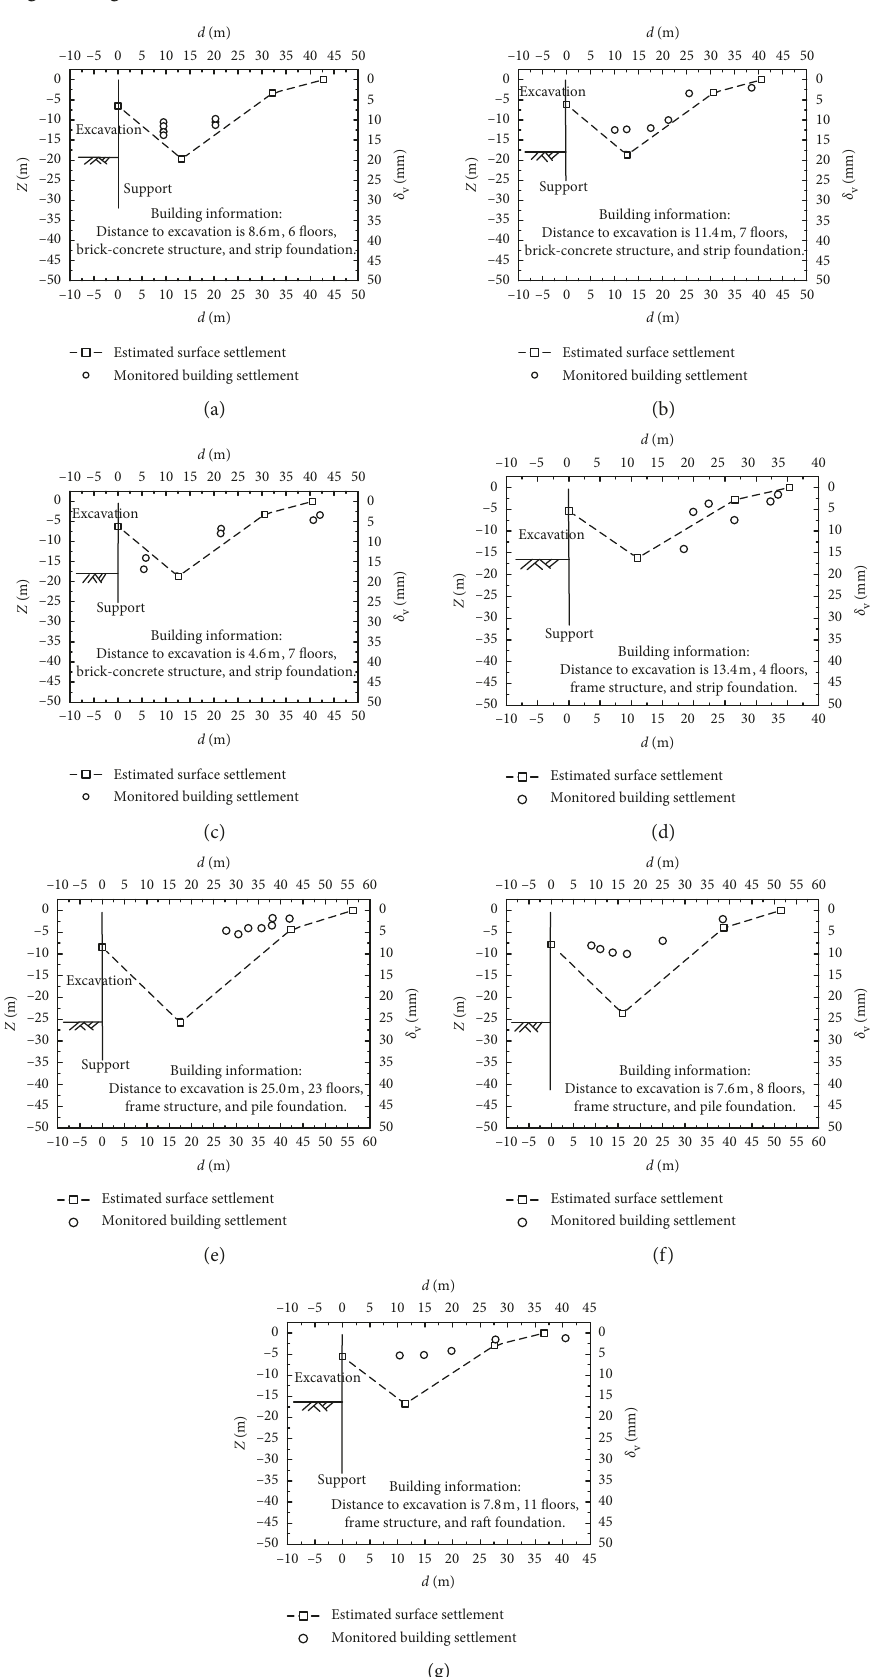
Figure 12: Building foundation settlements in zone A: (a) Xiaoshi Uptown Station: Shop Building; (b) Wuding Gate Station: Security Business Hall; (c) Wuding Gate Station: Wuzhou Motor Factory; (d) Mengdu Avenue Station: Aocheng Store; (e) Jimingsi Temple Station: Peace Mansion; (f) Daxinggong Square Station: Nanjing Library; (g) Jiulong Lake Station: Yihe